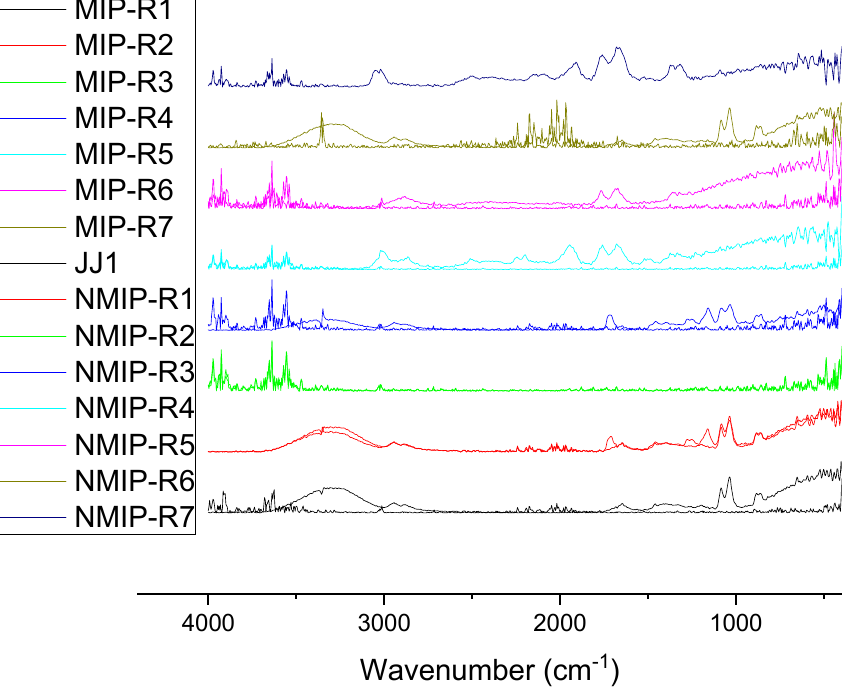
Figure 2. Demonstrating the FTIR spectrum for various samples compared to JJ1. X -axis here represents the wavenumber in inverse cm. The y -axis in this figure is not demonstrated, due to the samples being tiled above one another for easier appreciation of the